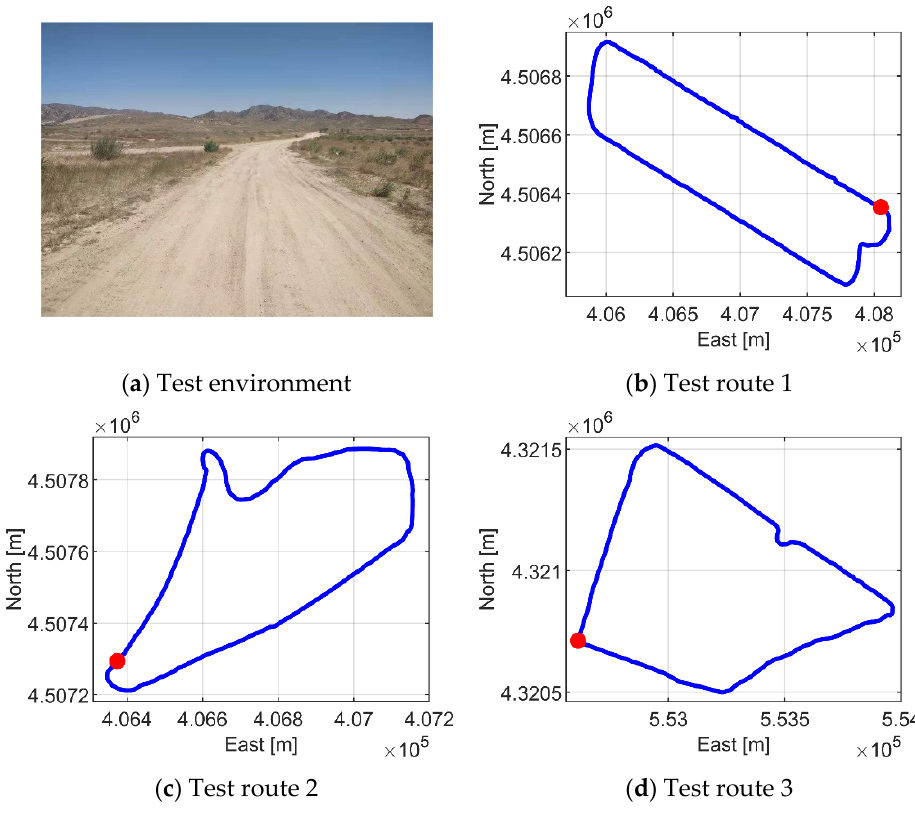
Figure 25. Test environment and route .